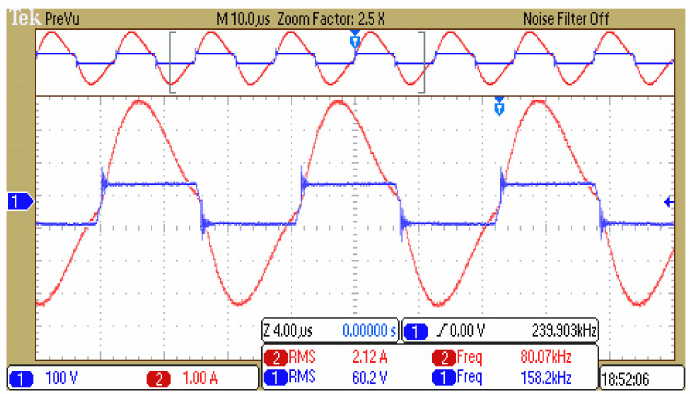
Figure 18. Inverter output voltage and